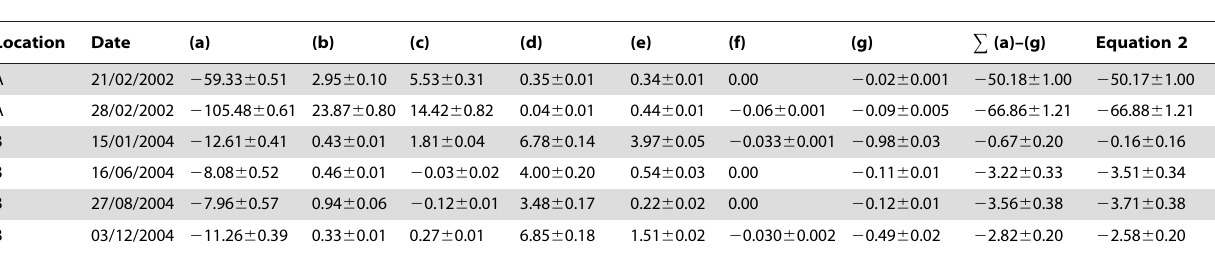
Table 3. Salt transport in the Espinheiro channel [kgm 2 1 s 2 1